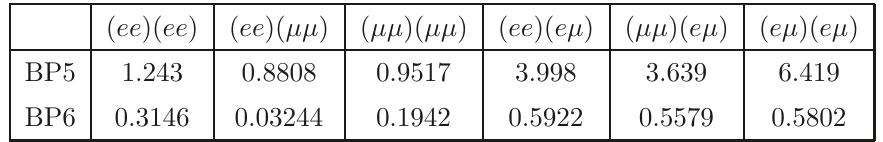
Table 13. Flavour composition of 4-displaced leptons in the